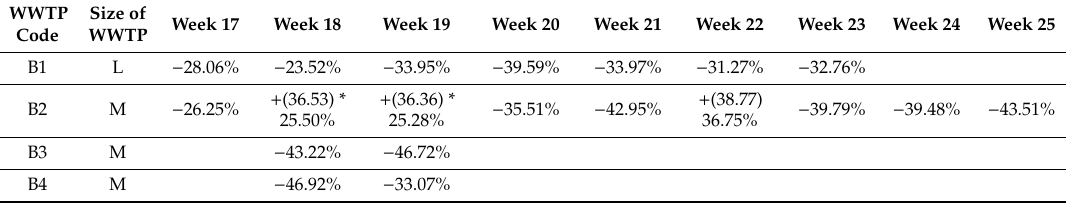
Figure 1. Regions of the Czech Republic where SARS-CoV-2 RNA was detected in wastewater. Based on the detection and quantification of TGEV (PCV), the mean efficiency of whole wastewater sample analysis was 35.53% with a standard deviation of 13.04. Cq ranging between 37 and 40 was achieved for seven (53.8%) influent wastewater samples, a lower Cq of 34–37 was also observed (six samples; 46.2%). Table 2. Results of SARS-CoV-2 RNA detection in wastewater samples obtained by EliGene COVID19 Basic A RT kit (Elizabeth Pharmacon, Brno, the Czech Republic). The results include processing efficiency calculated for each sample analyzed (%).